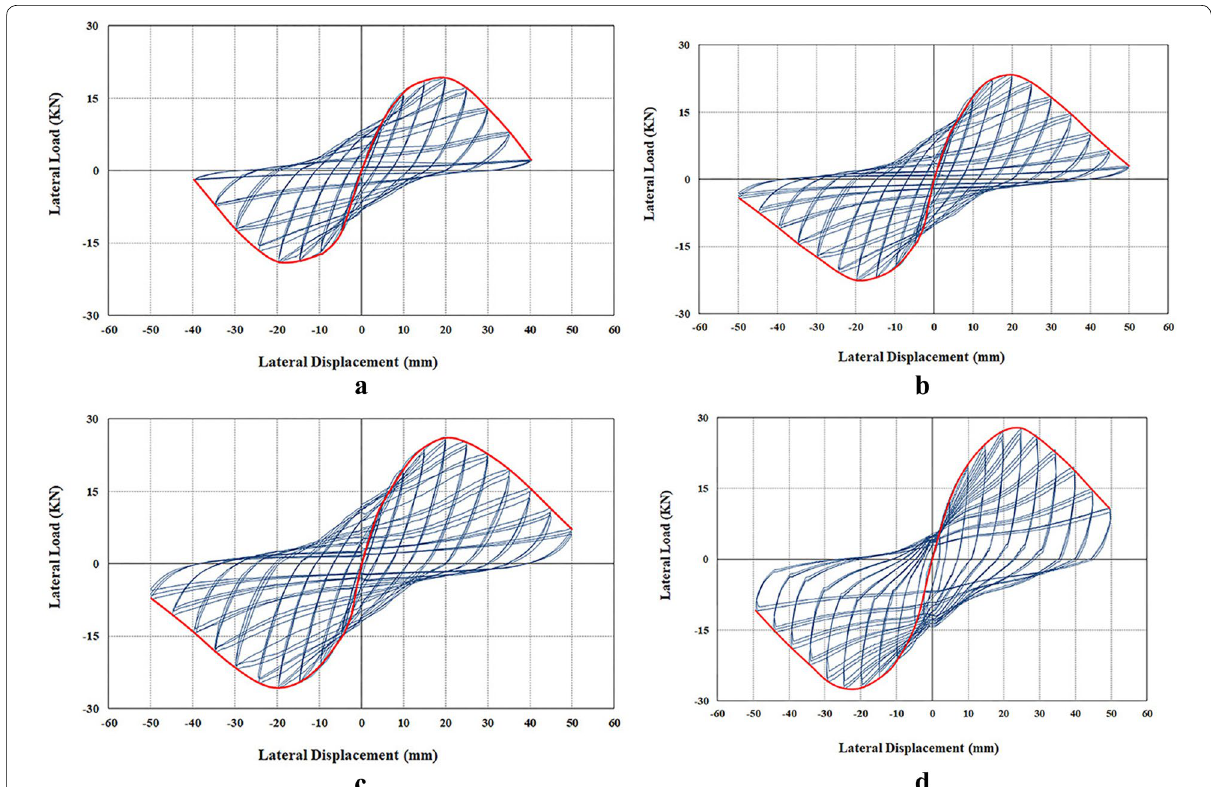
Fig. 5 Hysteresis curves for the specimens: a NS; b S08; c S10; d S12.